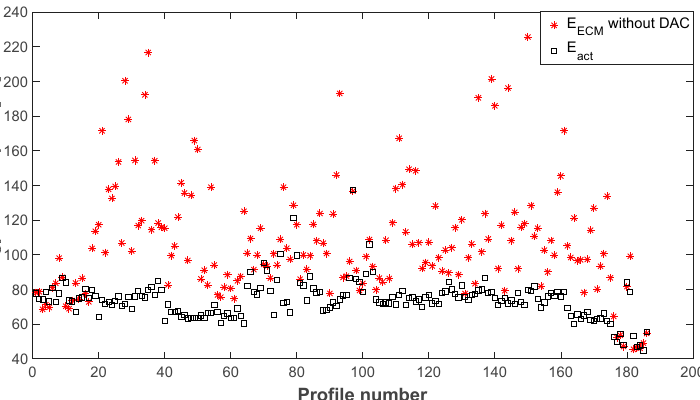
Figure 6. The actual energy consumption and energy consumption calculated by the ECM without considering the DAC.